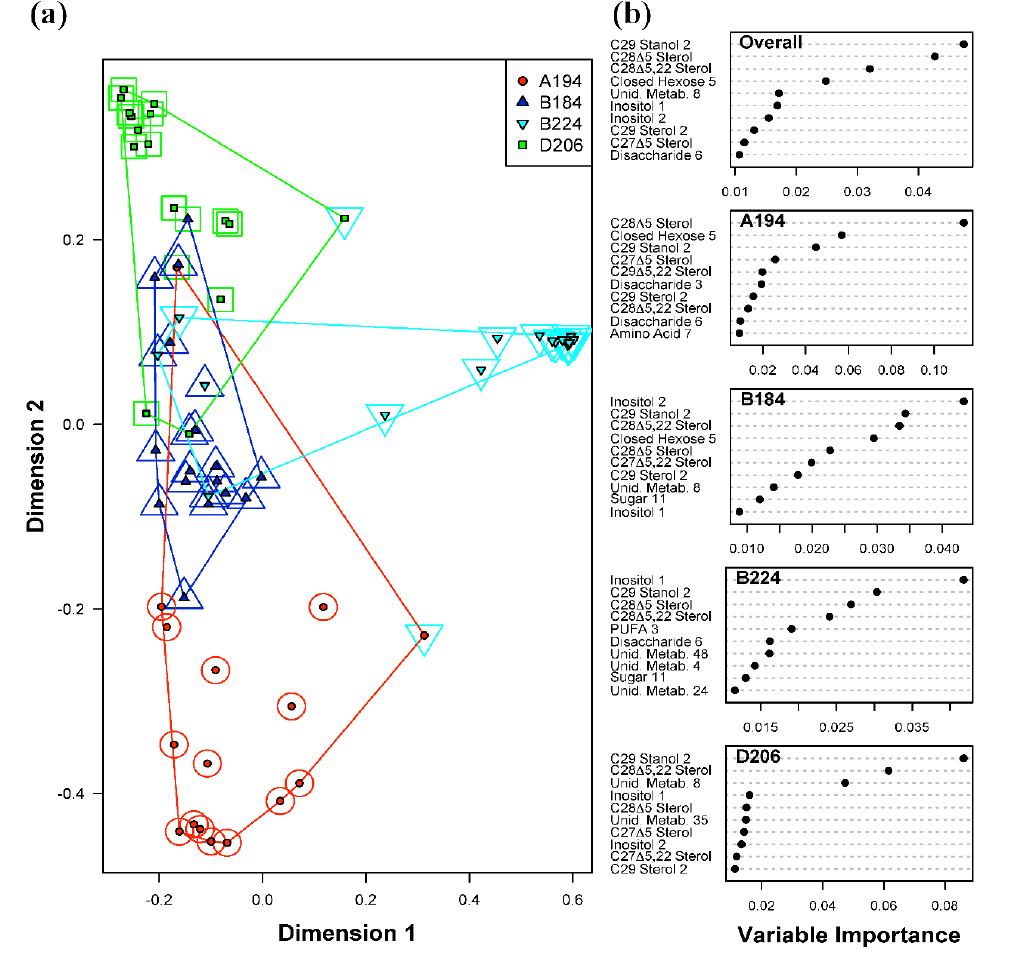
Figure 2. Random Forests classification of Symbiodinium type (A194, B184, B224 and D206). ( a ) Plot of proximities of all 64 samples from 5000 Random Forests trees as projected on the first two Principal Coordinate dimensions. Color and shape of the central filled points indicate the observed Symbiodinium type of the sample (A194, B184, B224 and D206), while the surrounding color and shape indicate the type predicted by Random Forests. Colored lines are convex hulls linking the outermost points of each type; ( b ) Distribution of importance scores for the 10 most important predictor metabolites (based on mean decrease in prediction accuracy). Plot labeled “Overall” depicts metabolites found to be important for overall prediction accuracy. Other plots show metabolites important for classifying each particular Symbiodinium